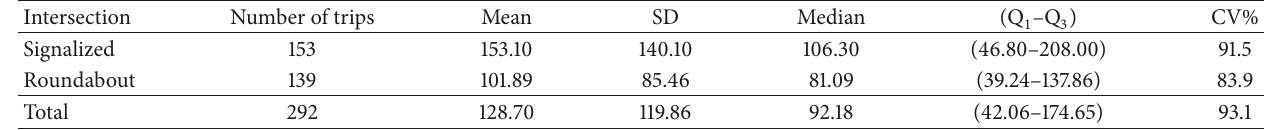
Table 10: Descriptive statistics for CO emissions (mg) by intersection type (traffic condition = peak).